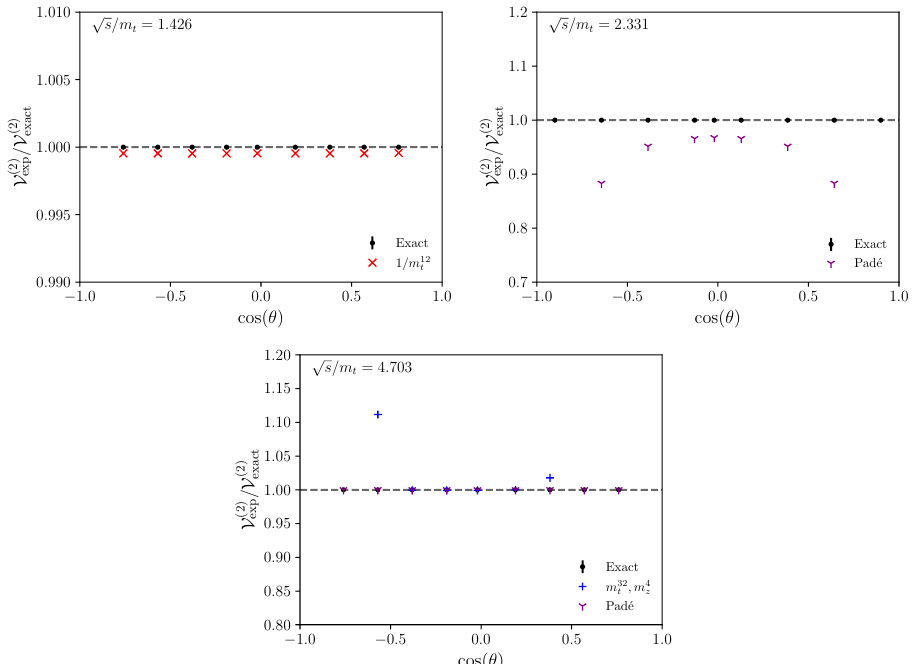
Figure 8. Comparison of the cos( θ ) dependence of the unpolarised interference V (2) with the results expanded in the limit of large top-quark mass for √ top-quark mass for s = 403 GeV (Top Right Panel) and